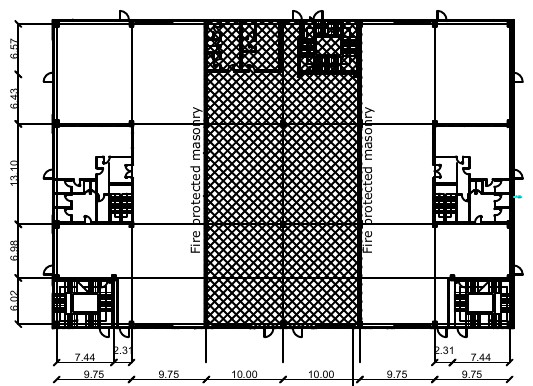
Figure 15: Zone interested by fire at the ground floor